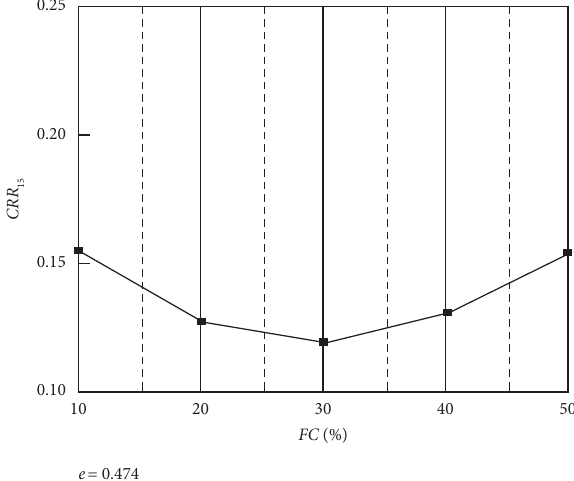
Figure 7: Correlations between the CRR 15 and FC of various mixtures at a constant e